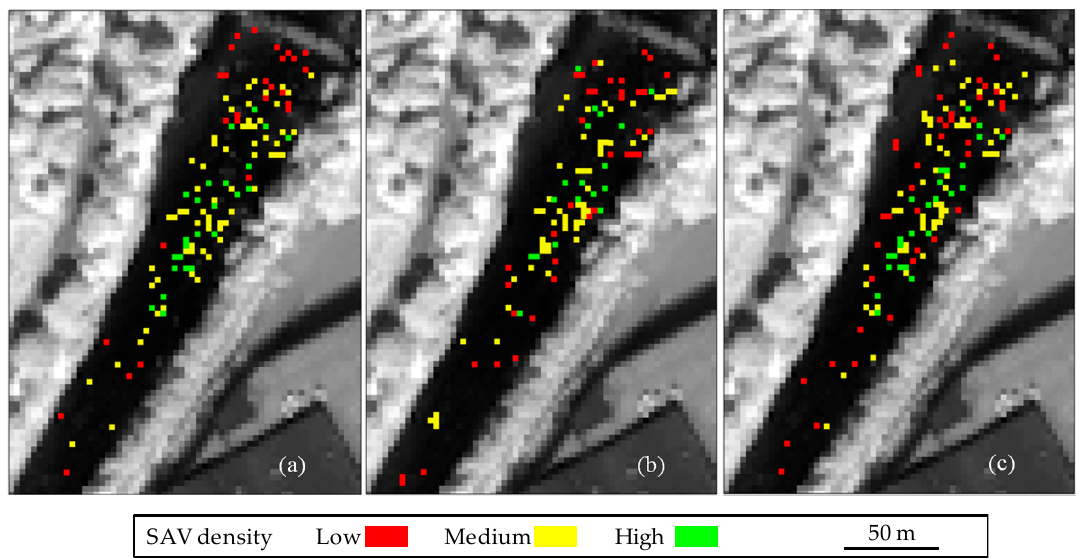
Figure 16. ( a ) In-situ map of SAV densities compared to the maps derived from clustering of the VI with (RE, R) band combination ( b ) before and ( c ) after water-column correction using the WV3 image.